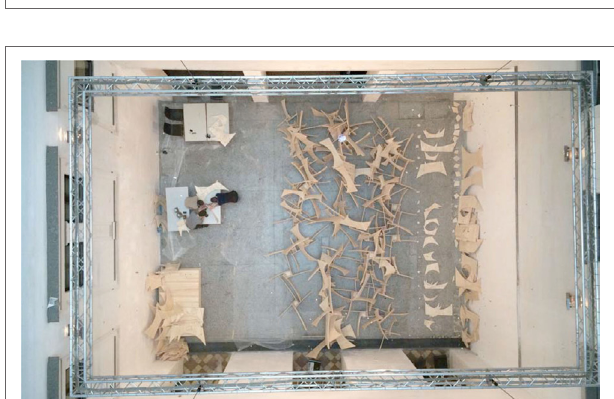
FIgURe 5 | CNC milling.